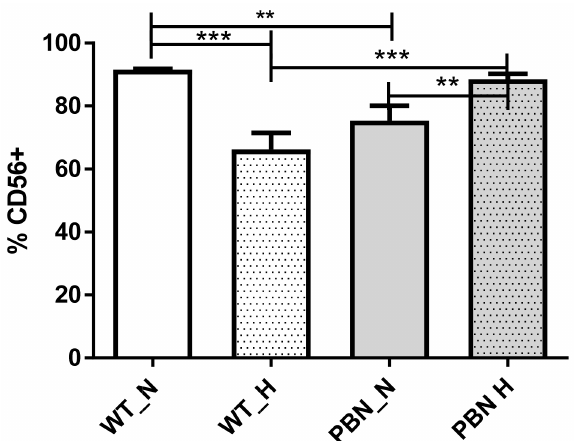
Figure 1. Percentage of CD56-positive skeletal muscle stem/progenitor cells (SkMDS/PCs) in in vitro culture. WT = wild-type SkMDS/PCs population, PBN = human SkMDS/PCs conditioned with N-tert-butyl- α -phenylnitrone; under standard in vitro culture conditions (N) and in hypoxia (H). ** significant at p value < 0.01, *** significant at p value <